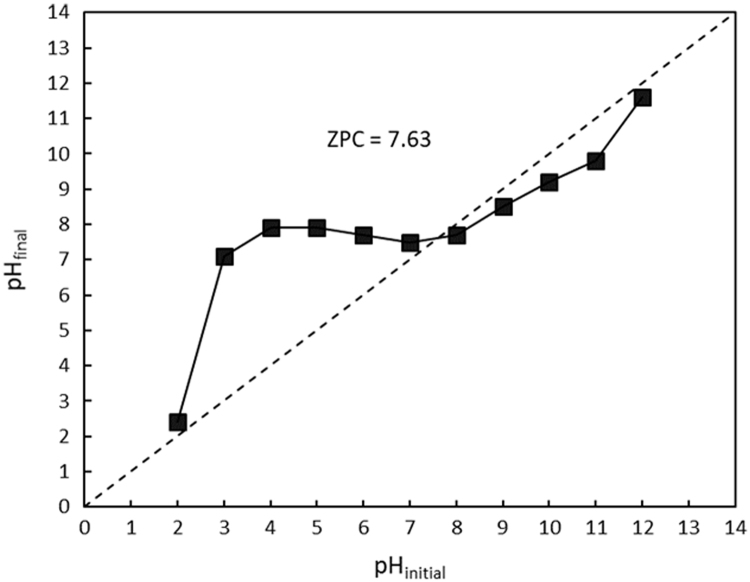
pHfinal vs. pHinitial for mixture of bagasse-bentonite.